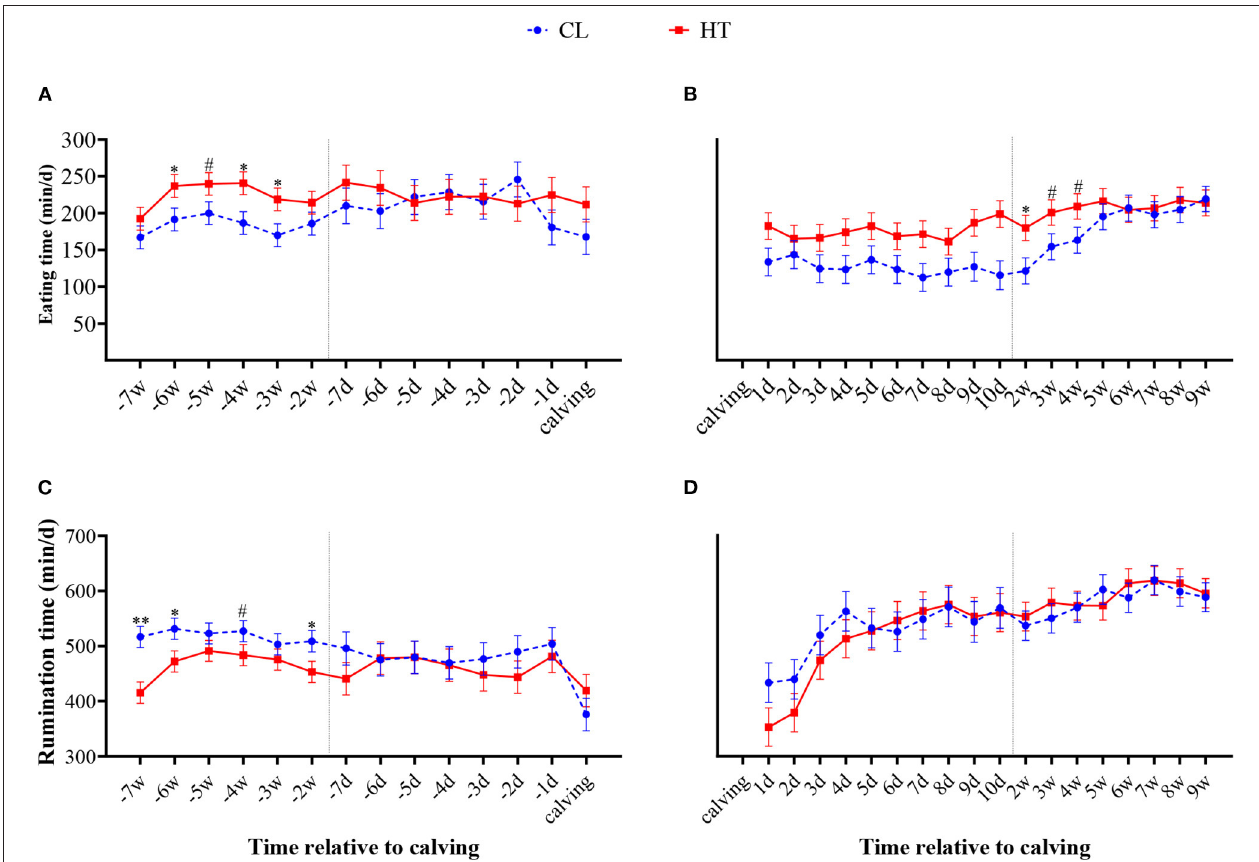
FIGURE 1 | Eating (A,B) and rumination (C,D) time (min/d) recorded from − 7 to 1 week before calving, from − 7 to 1 d before calving, from 1 to 10 d post calving, and from 2 to 9 weeks post calving in nulliparous Holstein heifers cooled by soakers and fans (CL, ) during the last 60 d of gestation and in heifers deprived of cooling (heat stress, HT, ). Animals of both treatments were cooled after parturition. Data are presented as LSM ± SEM and **indicates a treatment × time interaction of P < 0.01, *indicates P < 0.05 and # indicates 0.10 ≤ P >